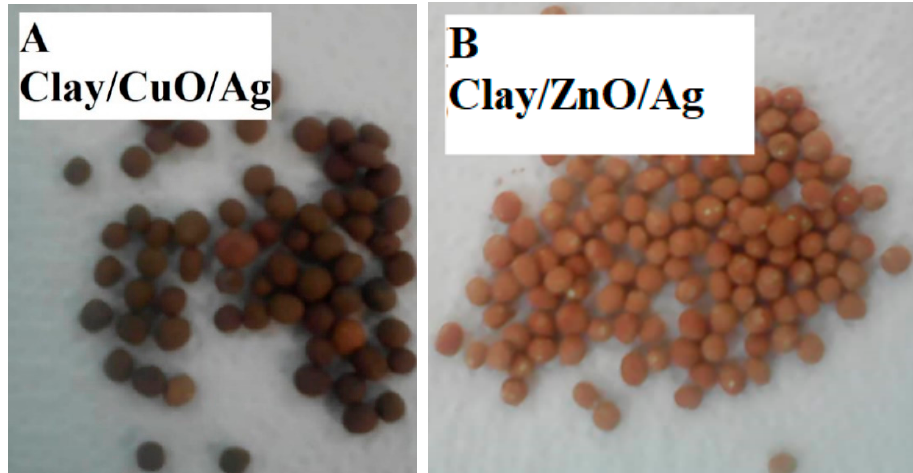
Figure 8. Synthesised clay–nanocomposite pellets of ( A ) CuO/Ag nanocomposite ( B ) ZnO/Ag nanocomposite.